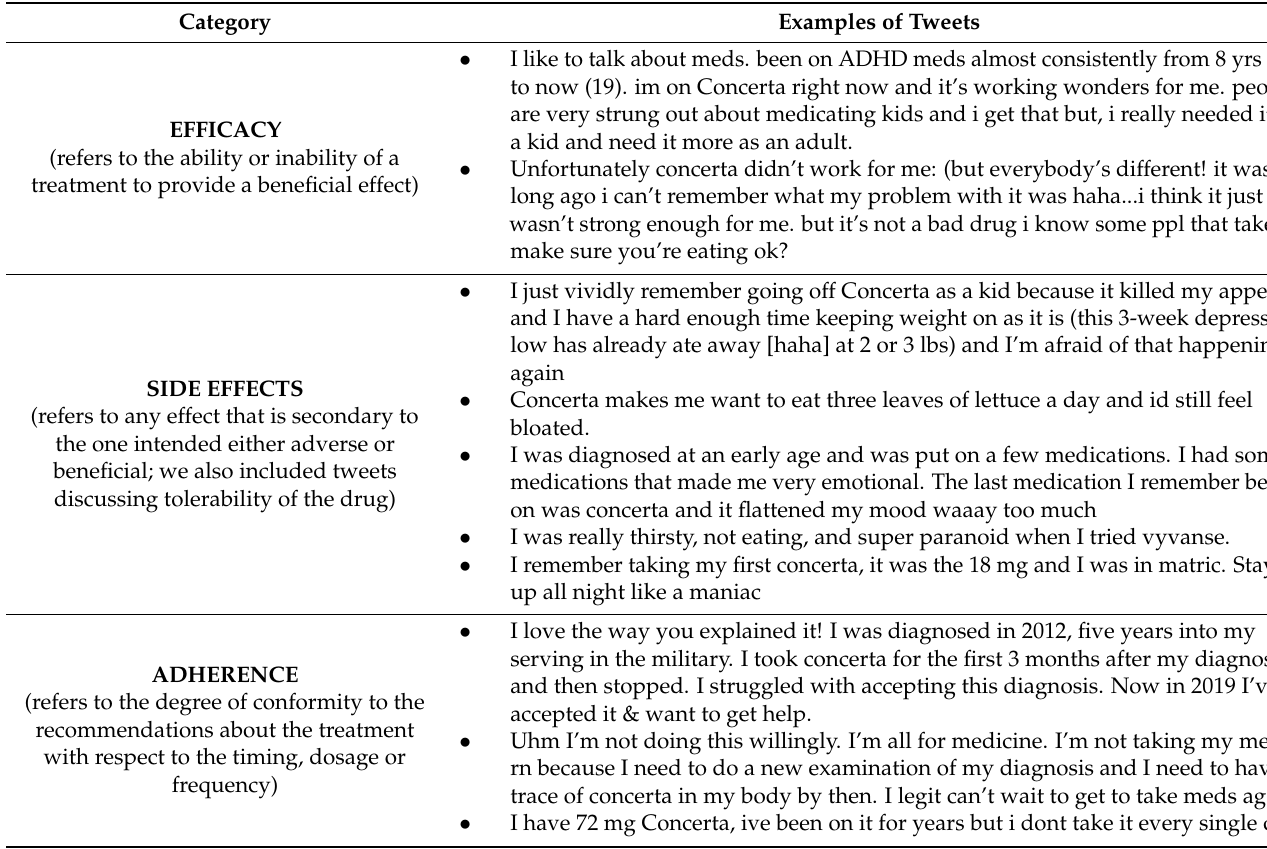
Table 1. Category, definitions and examples of classification. Usernames and personal names were removed. Category Examples of